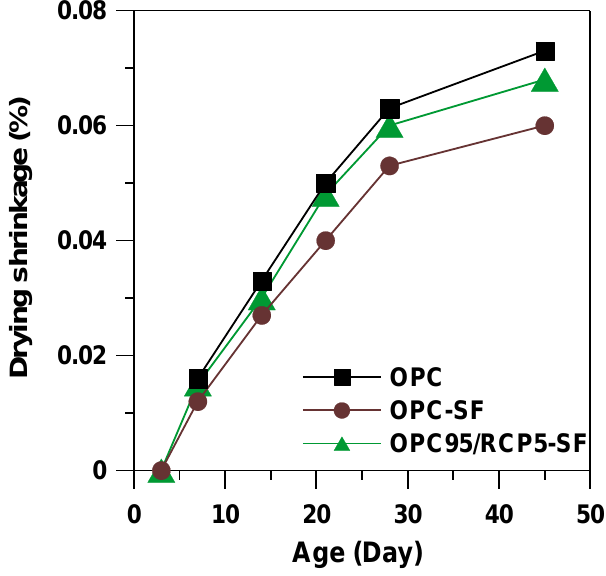
Figure 7. Drying shrinkage of OPC, OPC–SF, and OPC95/RCP5–SF